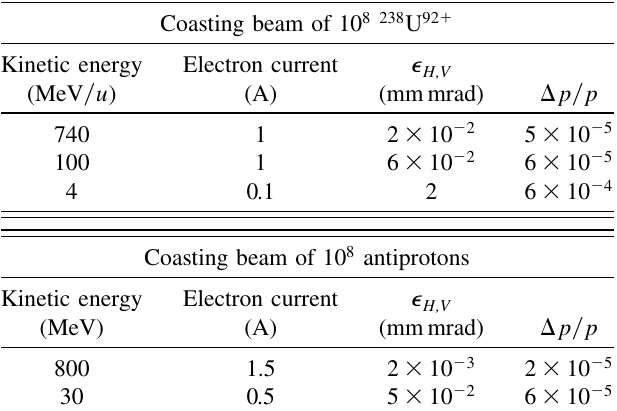
TABLE III. Equilibrium parameters ( 2 (cid:4) values) for electron- cooled ion and antiproton beams in the NESR.